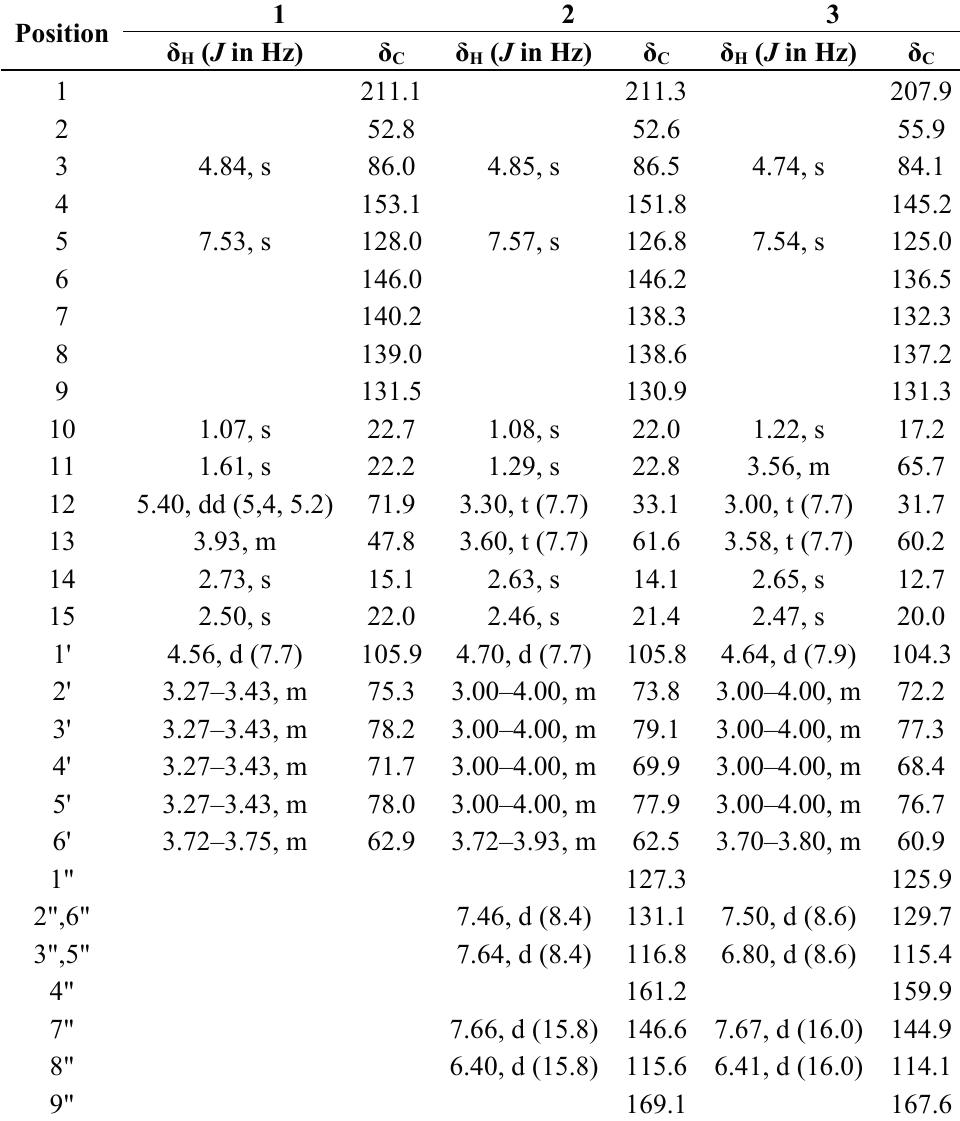
Table 1. 1 H- and 13 C-NMR spectra for compounds 1 , 2 and 3